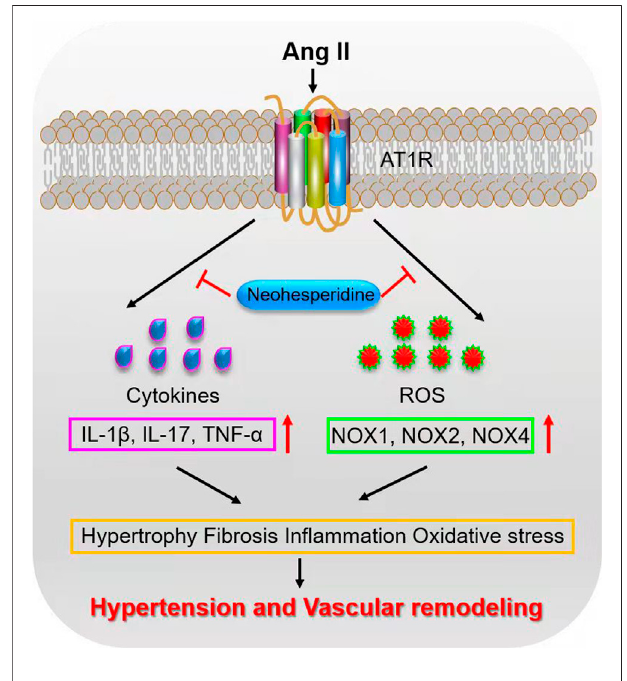
FIGURE 7 | Schematic diagram of the